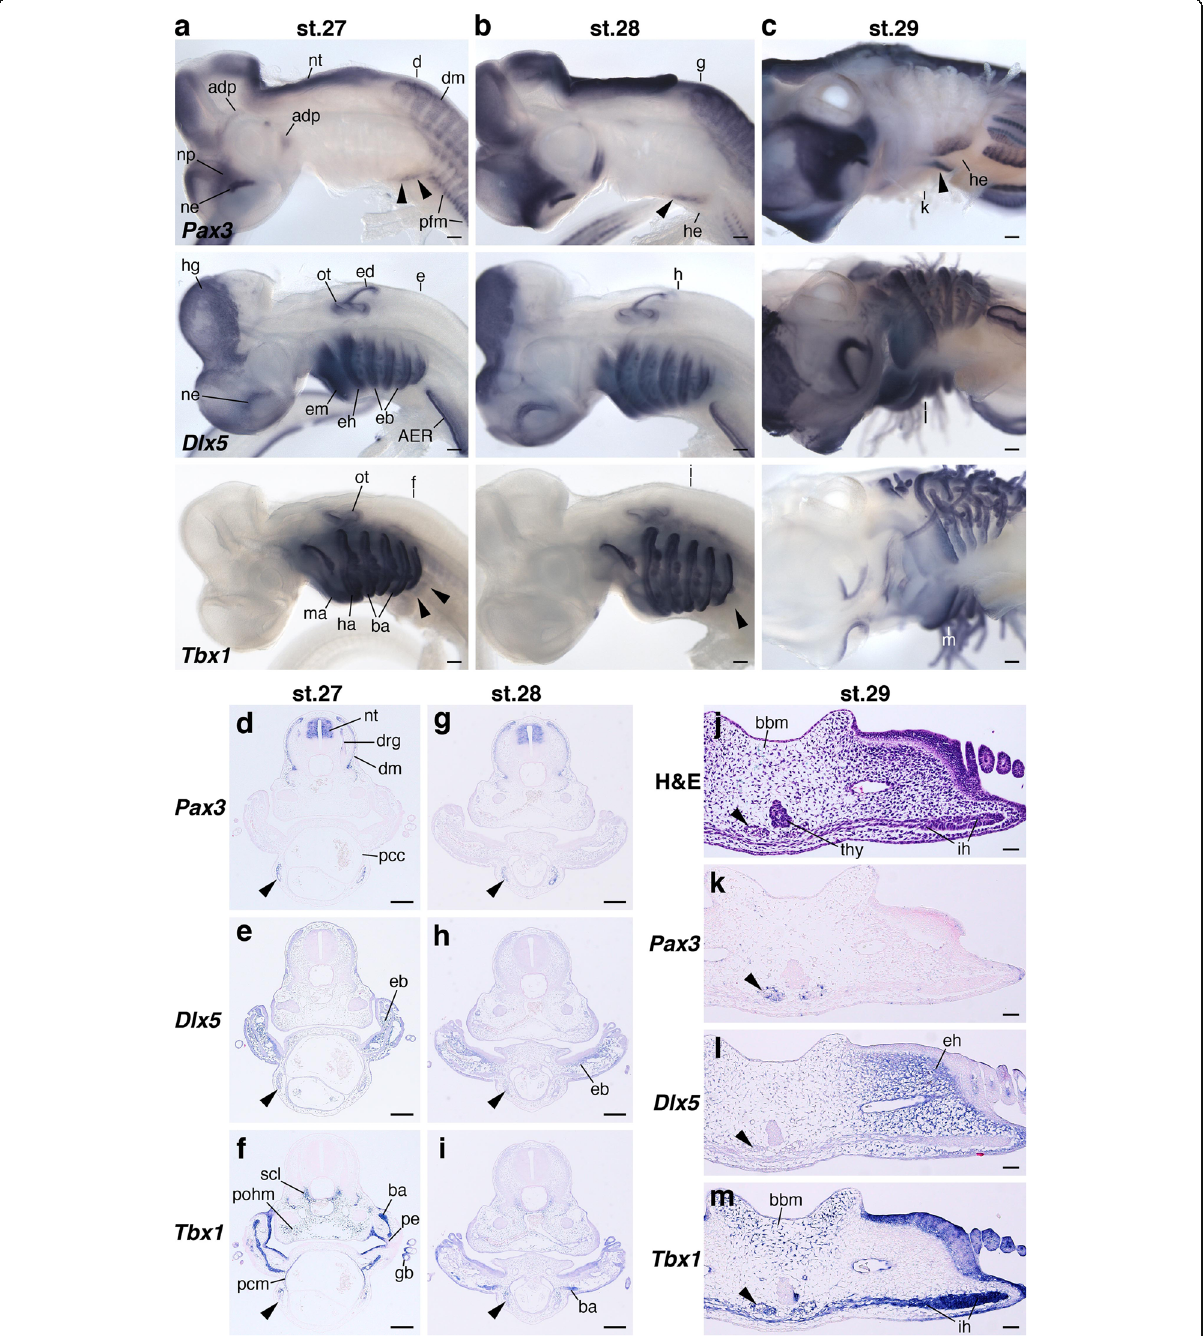
Fig. 6 The arrangement of HBMs pathways and pharyngeal arches in shark embryos. Pax3 , Dlx5 and Tbx1 expressions in sharks at stage 27 ( a ), 28 ( b ) and 29 ( c ). ( a , b ) Lateral and ( c ) ventrolateral views. Section in situ hybridization of Pax3 , Dlx5 and Tbx1 at stage 27 ( d – f ), 28 ( g – i ) and 29 ( k – m ). Transverse section levels are at the fourth branchial arch ( d – f ), the second branchial arch ( g – i ) and the hyoid arch ( j – m ), as indicated in ( a ), ( b ) and ( c ). Arrowheads indicate HBM precursors. Pharyngeal arches and the pericardium were in the same transverse plane. Note that HBM precursors passed through the lateral side of pericardium, and then extended medially at the hyoid arch. Adp, anterodorsal lateral line placode; AER, apical ectodermal ridge; ba, branchial arch mesoderm; bbm, basibranchial mesenchyme; dm, dermomyotome; drg, dorsal root ganglion; eb, ectomesenchyme of branchial arches; ed., endolymphatic duct; eh, ectomesenchyme of hyoid arch; em, ectomesenchyme of mandibular arch; gb, gill bud; ha, hyoid arch mesoderm; he, heart; hg, hatching gland; ih interhyoideus; ma, mandibular arch mesoderm; ne, nasal epithelium; np, nasal prominence; nt, neural tube; ot, otic vesicle; pcc, pericardial cavity; pcm, pericardial mesoderm; pe, pharyngeal endoderm; pfm, pectoral fin muscle; pohm, postotic paraxial head mesoderm; scl, sclerotome; thy thyroid gland. Scale bars on whole embryos, 200 μ m. Scale bars on sections, 50 μ